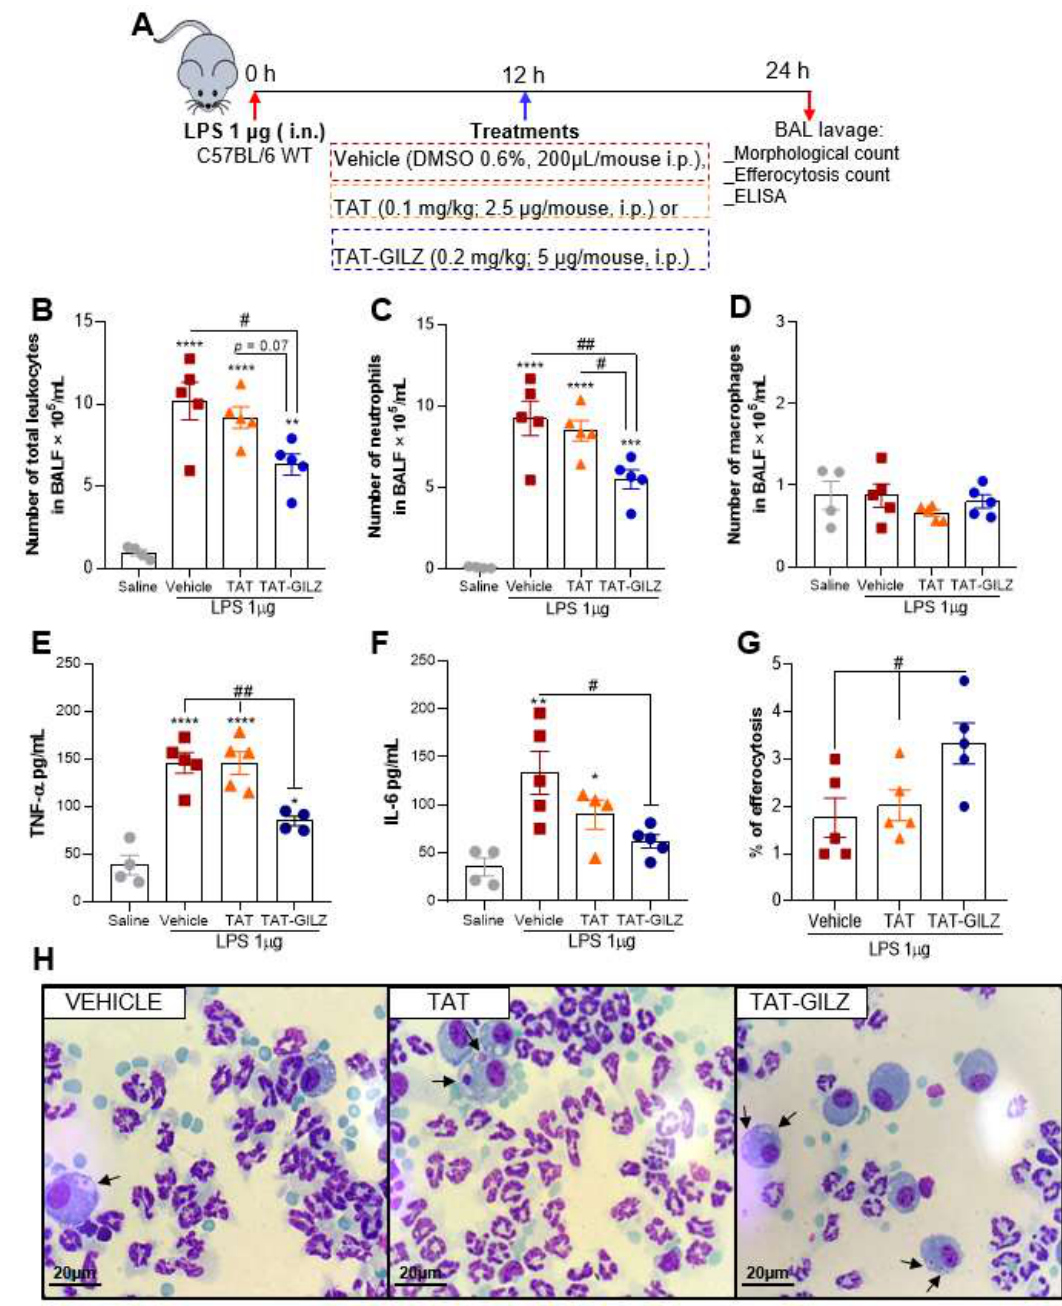
Figure 3. TAT-GILZ treatment during LPS-induced ALI modulates neutrophilic inflammation and increases efferocytosis indexes. C57BL/6 WT mice were stimulated with LPS (1 µ g, i.n.), treated with TAT (0.1 mg/kg, i.p.) or TAT-GILZ (0.2 mg/kg, i.p.) 12 h p.i., and euthanized 24 h later (schematic protocol in ( A )). BAL was harvested to quantify number of total leukocytes ( B ), neutrophils ( C ) and macrophages ( D ). Levels of the cytokines TNF- α ( E ) and IL-6 ( F ) were measured by ELISA in BAL fluid. Graph ( G ) shows the percentage of efferocytosis by morphological counting of cytospin slides stained with May-Grunwald-Giemsa. In ( H ), arrows indicate apoptotic neutrophils inside macrophages. Magnification 100 × . Vehicle group received DMSO 0.6%. Data are mean ± SEM of N = 4–5 animals per group. * p < 0.05, ** p < 0.01, *** p < 0.001 or **** p < 0.0001 when compared to saline instilled groups; or as indicated: # p < 0.05, ## p < 0.01 or p = 0.07 when comparing TAT-GILZ- treated LPS-challenged mice to vehicle or TAT groups, by 1-way